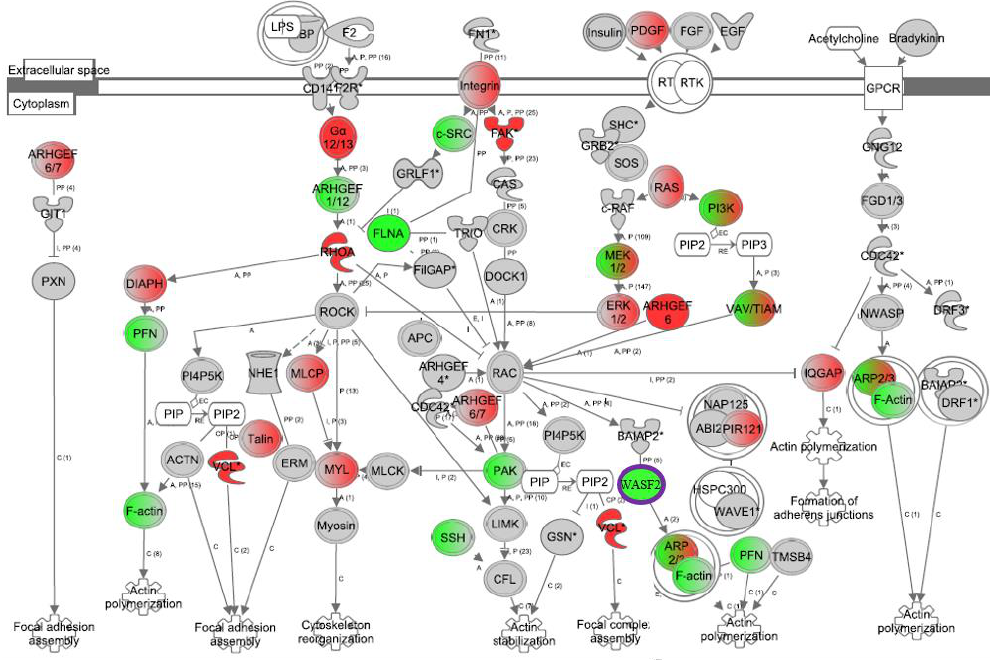
Figure 2. Gene expression analysis of the actin cytoskeleton in hypertensive women. Microarray gene expression fold changes in PBMCs isolated from AANT, WNT, AAHT, and WHT were imported into Ingenuity Pathway Analysis (IPA) and overlaid onto the actin cytoskeleton pathway. In this figure, red indicates significantly upregulated expression and green indicates significant downregulation in AAHT compared with WHT. Grey indicates a non-significant difference and white indicates no data available. Nodes with green and red represent the differences for those nodes with two genes functionally interacting or genes with transcript variants. All fold changes and P-values are listed for each gene and each comparison in Supplementary Materials Table S1 and transcript variant information is available at GSE75672. AANT: African American normotensive women; AAHT: African American hypertensive women; WNT: white normotensive women; WHT: white hypertensive women.